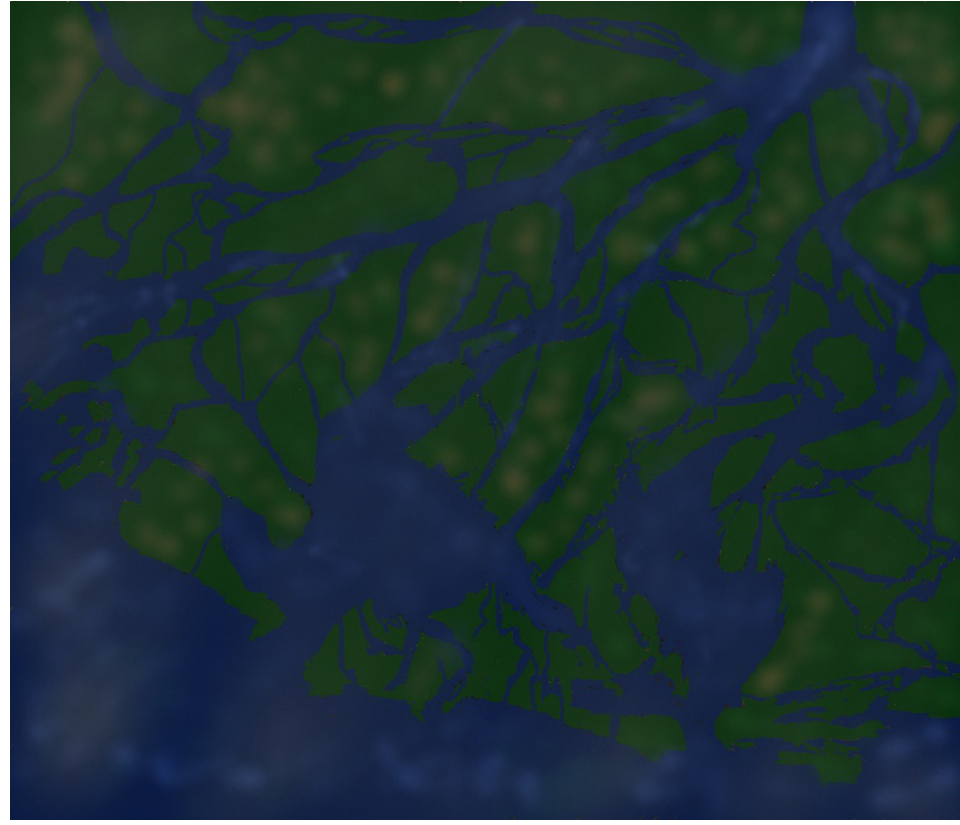
Blue and green hand-drawn aerial view of a river